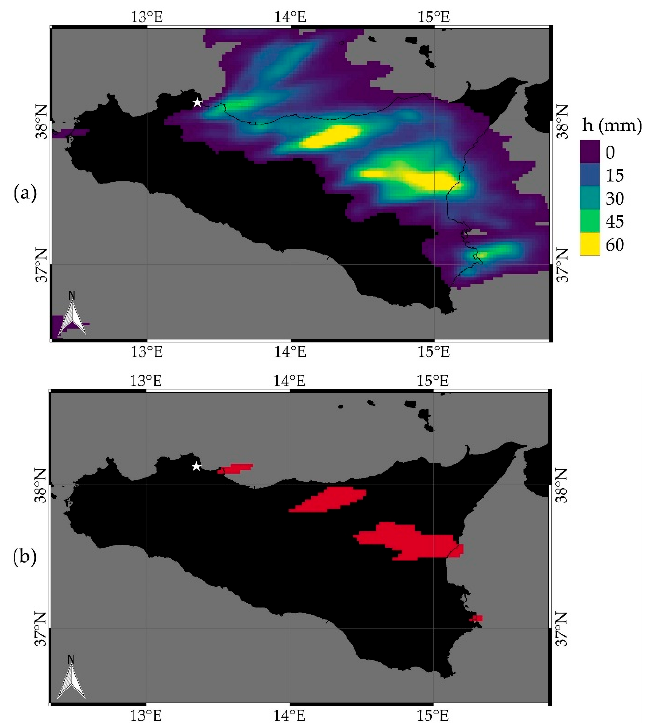
Figure 9. The maps show the rainfall depths evaluated using the 2.5 km resolution 48 h rainfall forecast of the 15 July 12:00 UTC model run ( a ) and the heavy rainfall alerts issued by ERDS using the 2.5 km resolution 48 h rainfall forecast of the 15th July 12:00 UTC model run ( b ). The white star represents the position of Palermo.